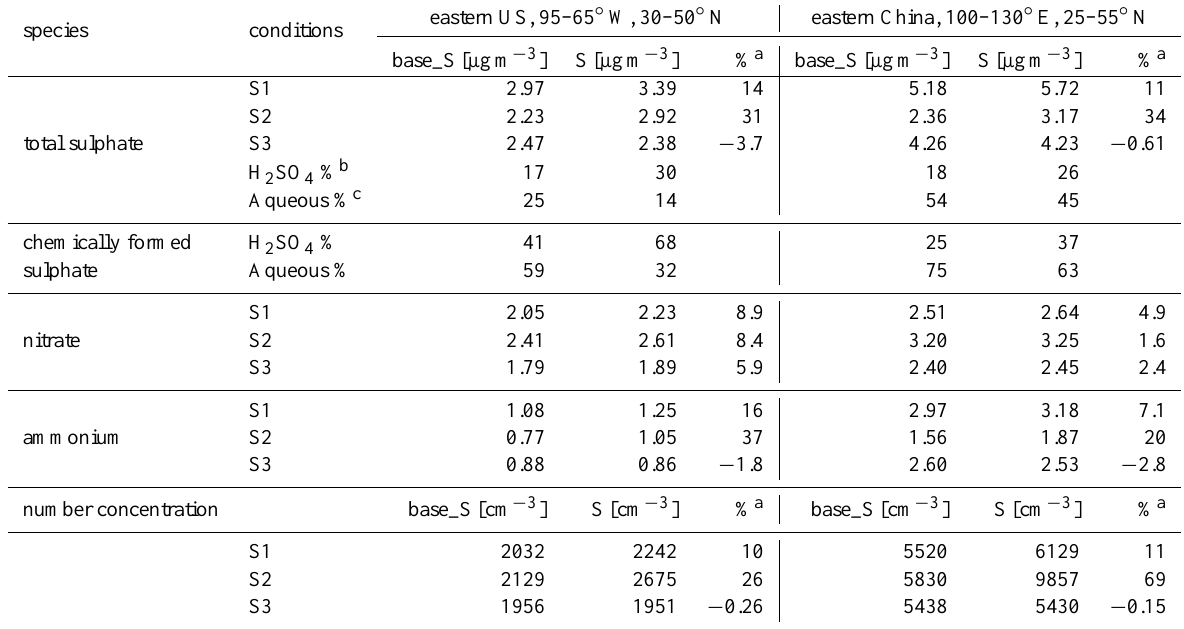
Table 2. Contributions of the different chemical processes to the simulated aerosol sulphate, nitrate and ammonium concentrations and their relative enhancement as a result of simulating realistic HONO levels during January in the eastern US and